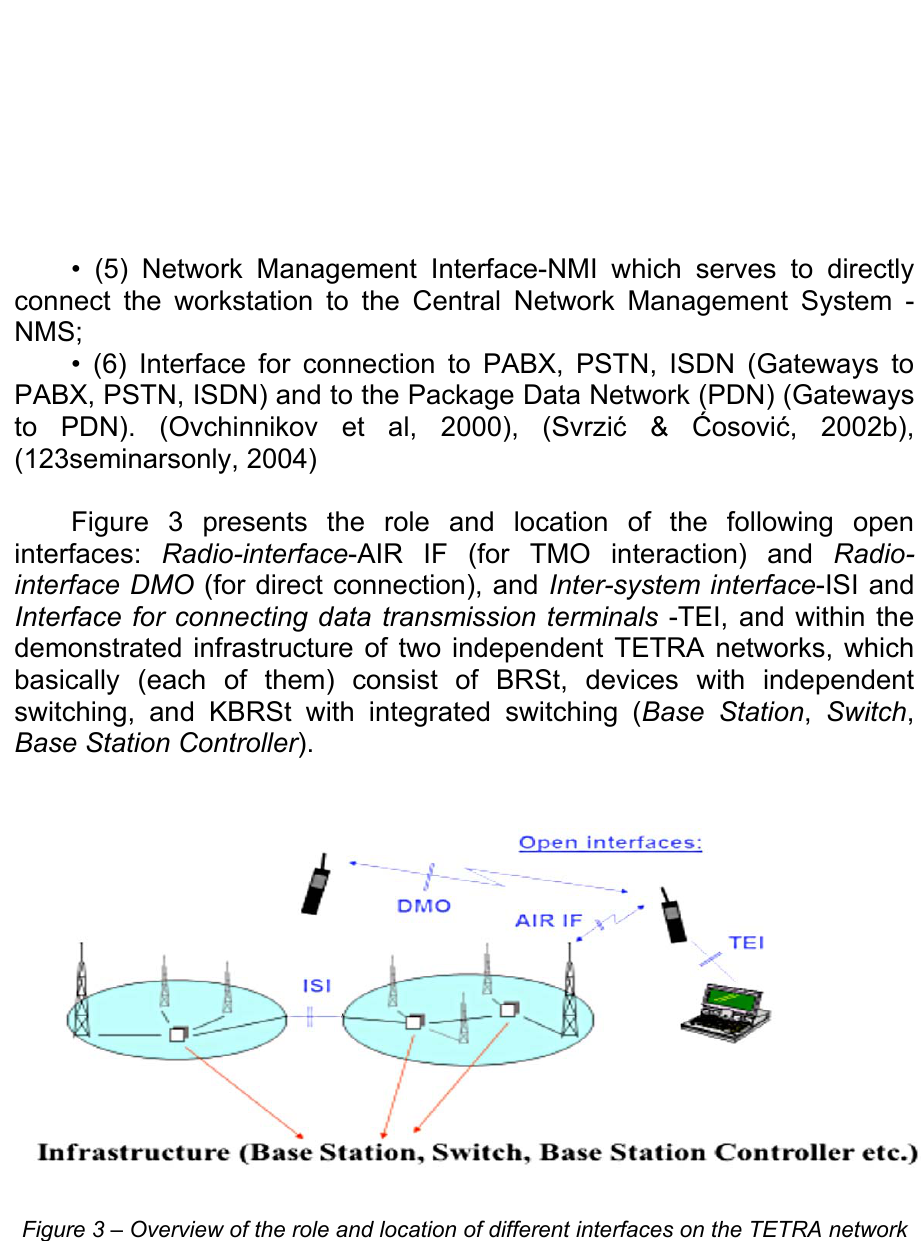
Figure 3 – Overview of the role and location of different interfaces on the TETRA network infrastructure (123seminarsonly,